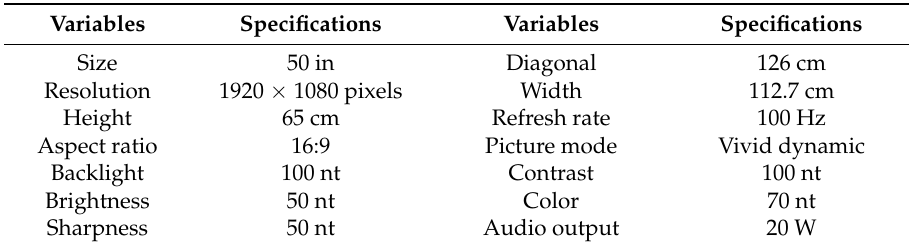
Table 1. Specifications of 3D LG Smart